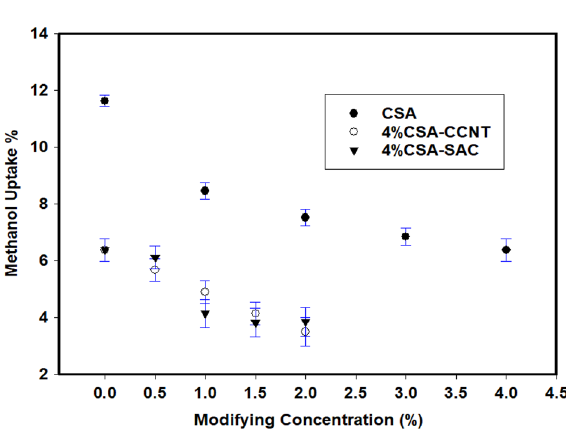
Figure 4. Methanol uptake of CMC/PVA/AA and modified CMC/PVA/AA hybrid polyelectrolytic membranes with different amounts of CSA, CCNT and